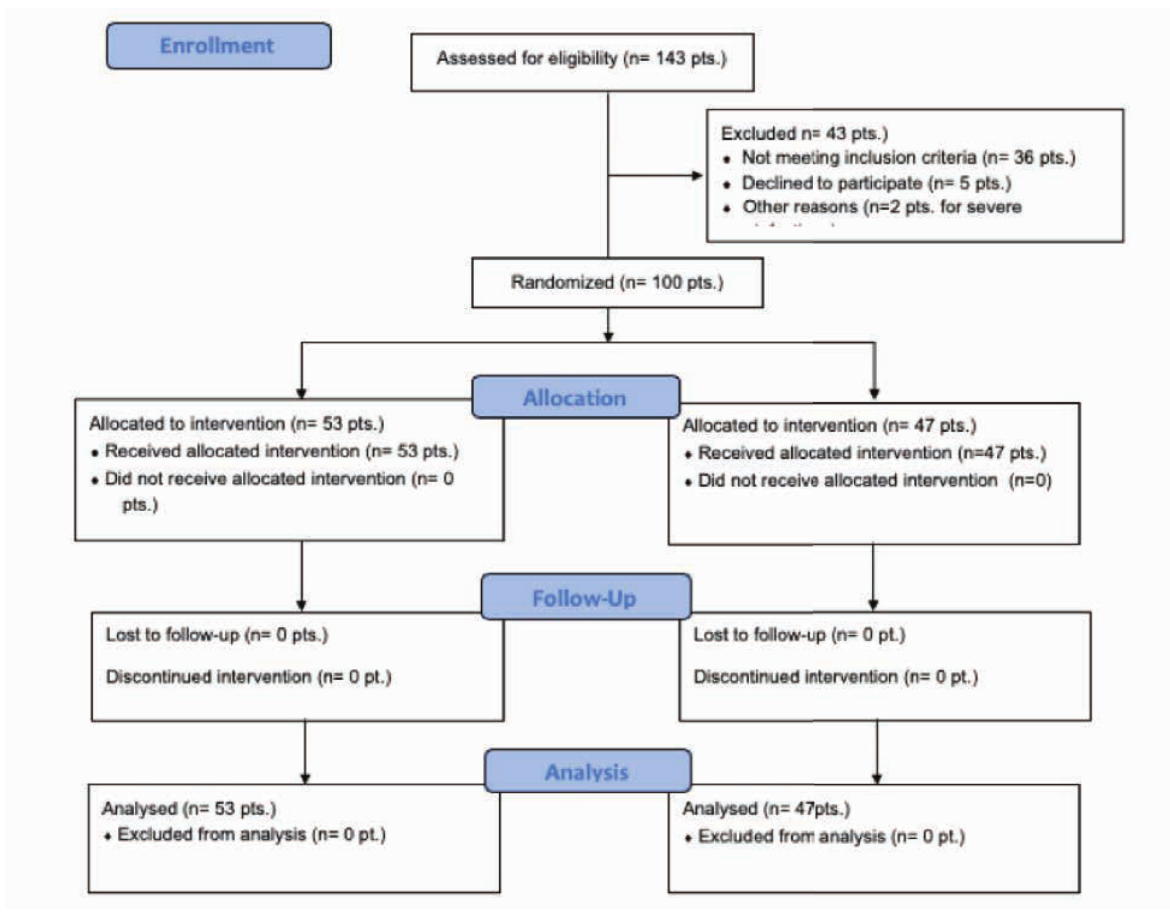
Figure 1: Consort checlist